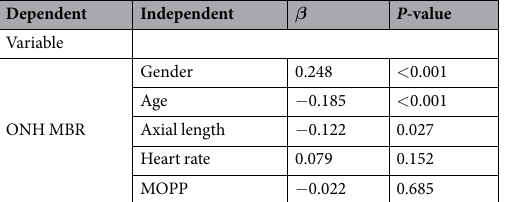
Table 3. Result of multiple stepwise regression analysis for independence of factors not including laboratory data contributing to ONH MBR. ONH: optic nerve head; MBR: mean blur rate; MOPP: mean ocular perfusion pressure.